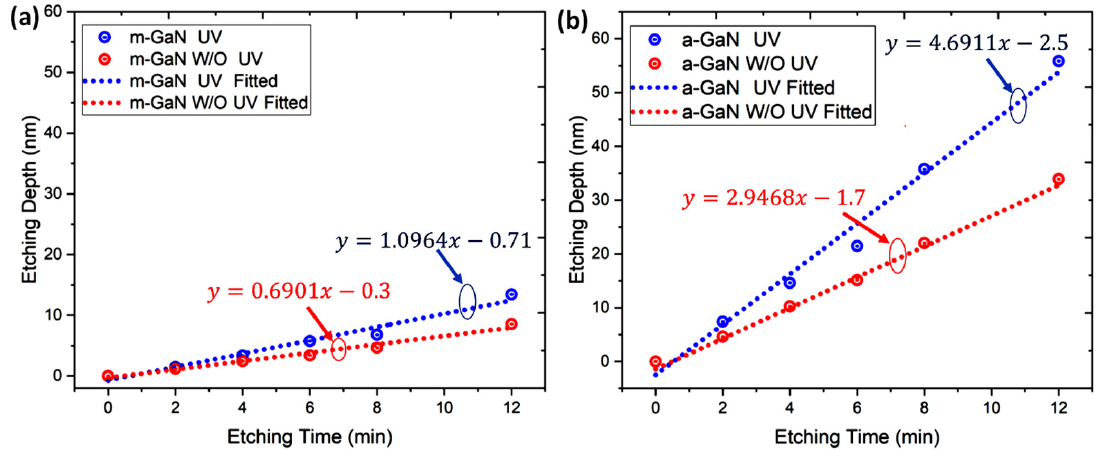
Figure 5. m-GaN and a-GaN wet etching rate in TMAH solution with and without UV-source. ( a ) for m-GaN plane, ( b ) for a-GaN